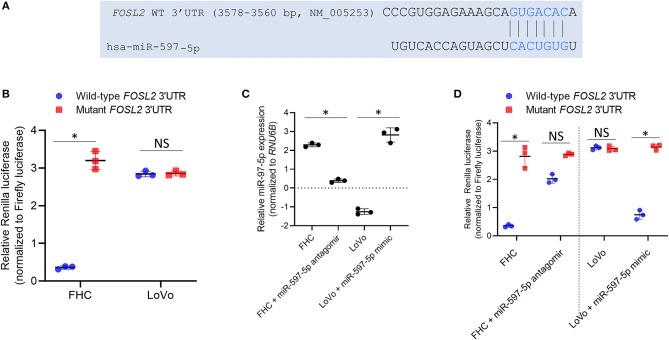
FOSL2 is targeted by miR-597-5p in colon cells. (A) Schematic representation of complementarity of FOSL2 3′ UTR and miR-597-5p seed sequence. (B) Relative Renilla luciferase activity of constructs with wild type 3′ UTR of FOSL2 or its mutant (with deletion of miR-597-5p binding site) in FHC and LoVo cells. (C) QRT-PCR analysis of miR-597-5p in FHC and LoVo cells transfected with miR-597-5p antagomir and mimic, respectively. (D) Relative Renilla luciferase activity of constructs with wild type or mutant FOSL2 3′ UTR of in FHC and LoVo cells, alone or in combination with anti-miR-597-5p antagomir or miR-597-5p mimic, respectively. All data in (B–D) are expressed as mean ± SD of three independent experiments. *P < 0.05; NS, non-significant.